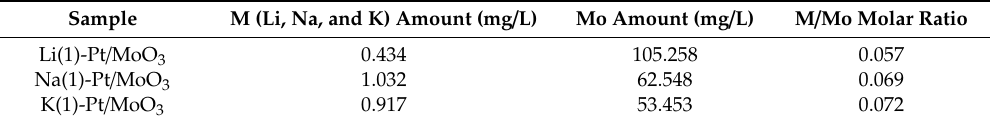
Table 2. Inductively coupled plasma (ICP) results of the ion intercalated MoO